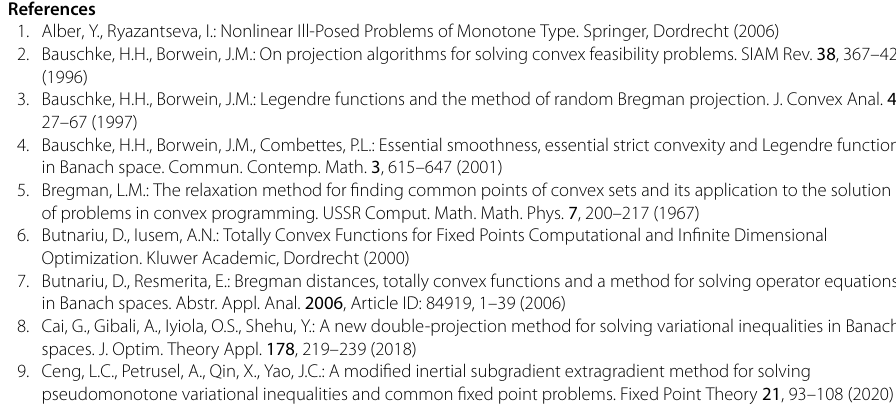
) against a number of iterations using (cid:10) x n +1 3